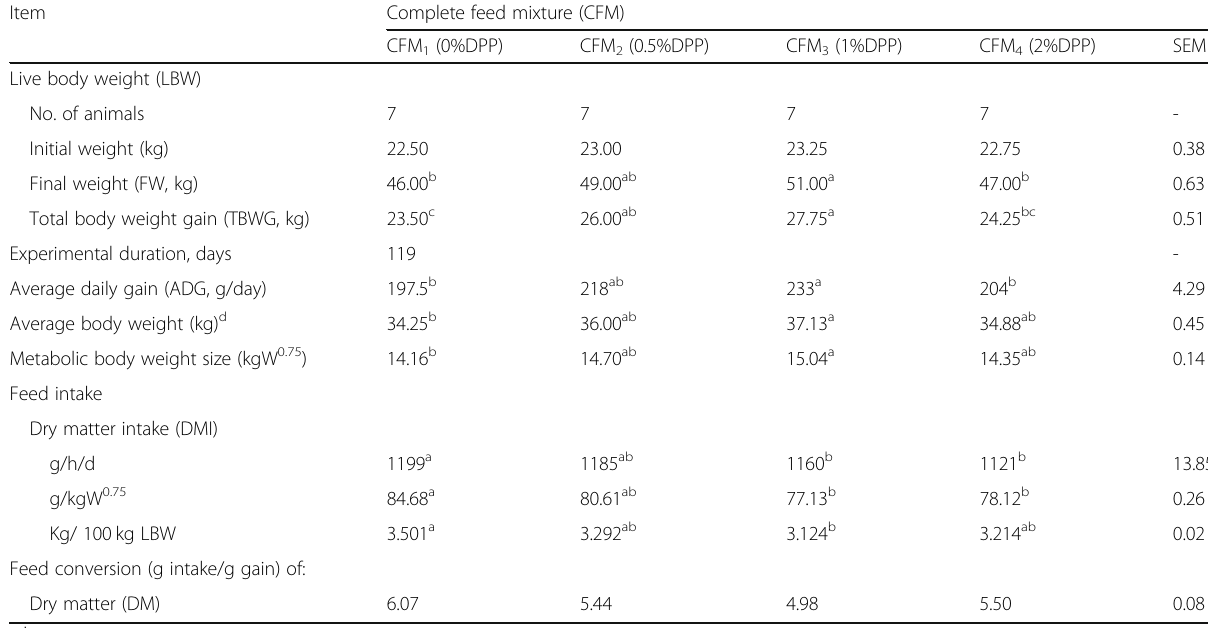
Table 8 Growth performance of experimental groups